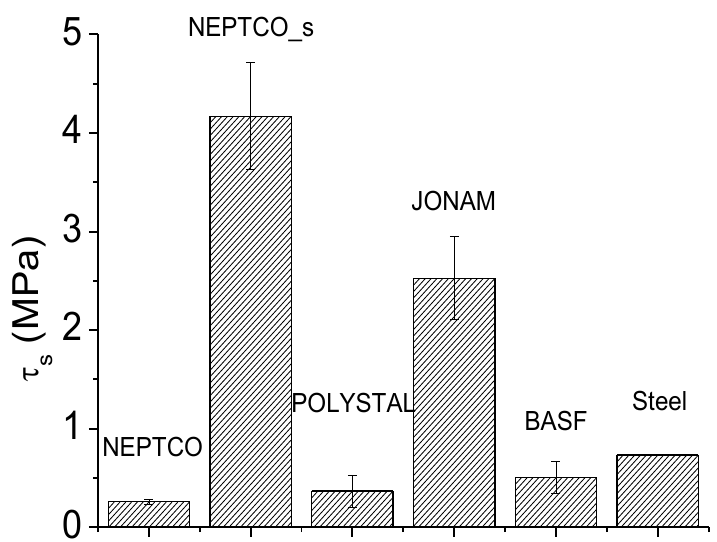
Figure 9. Adhesion strength for different